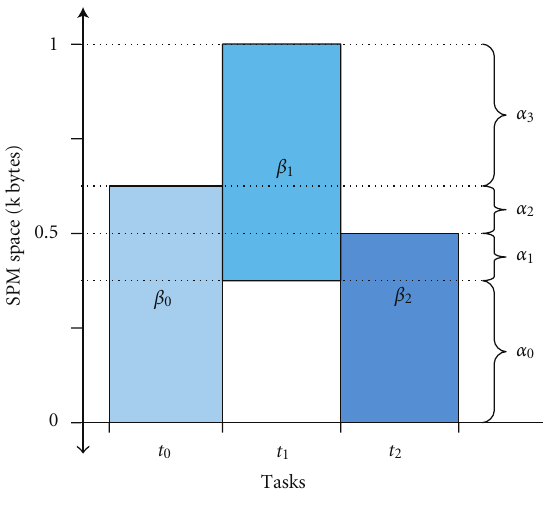
Figure 13: SPM partitioned into